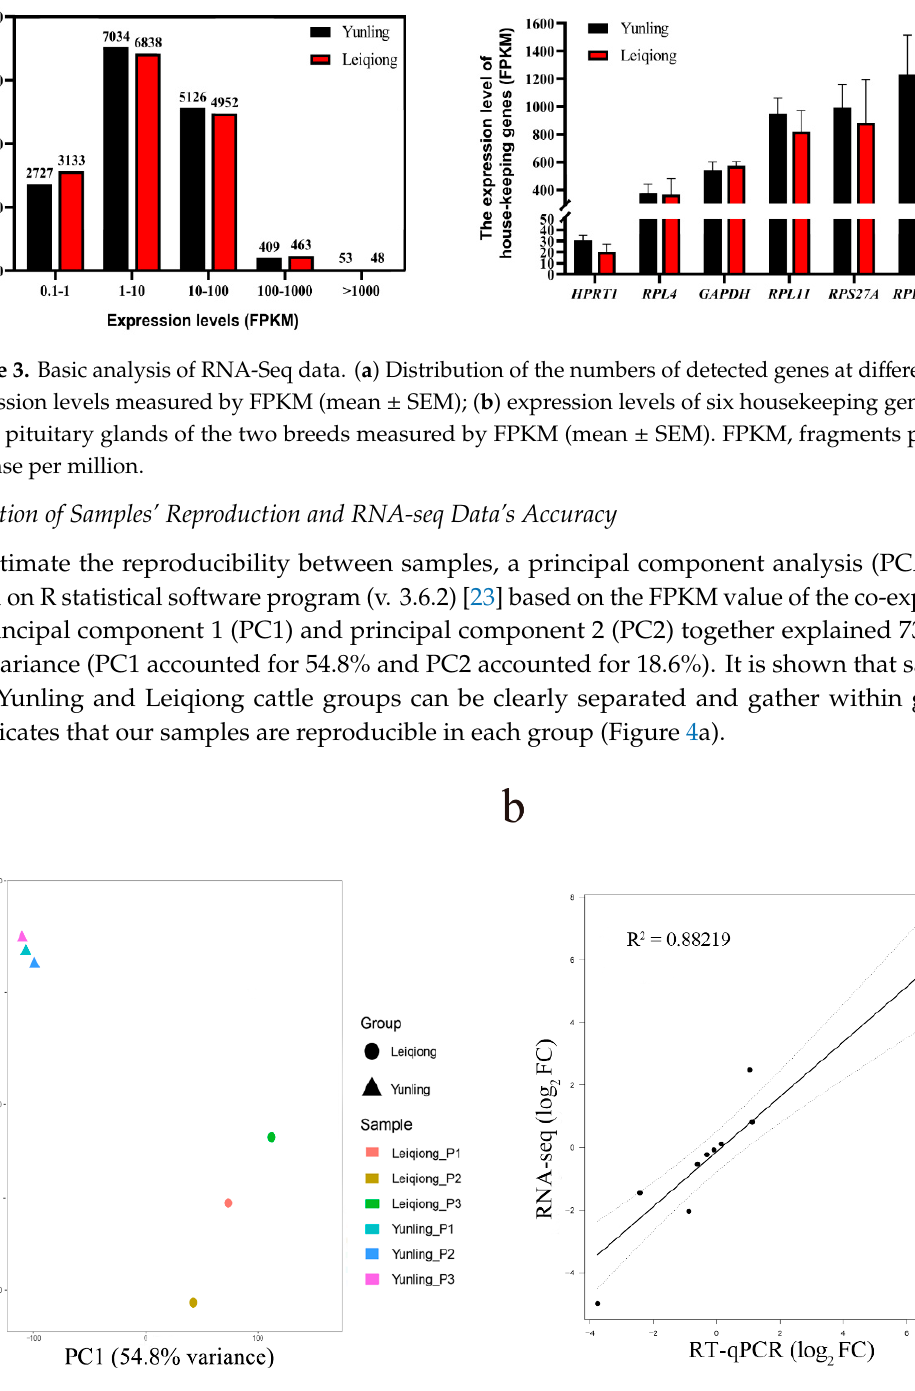
Figure 4. Validation of the accuracy of data. ( a ) Principal component analysis (PCA) results of the profiling data (circles represent Yunling cattle and triangles represent Leiqiong cattle); ( b ) correlation between RNA-seq and qRT-PCR data. The correlation coefficient between RNA seq ( y -axis) and RT-qPCR ( x -axis) data (log 2 fold change) was analyzed by a Pearson test. R 2 is 0.88219 with a statistical significance of p < 0.05.